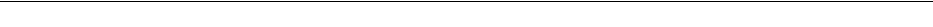
Figure 3. Organic Food Access for Black Households in Manhattan, New York, January